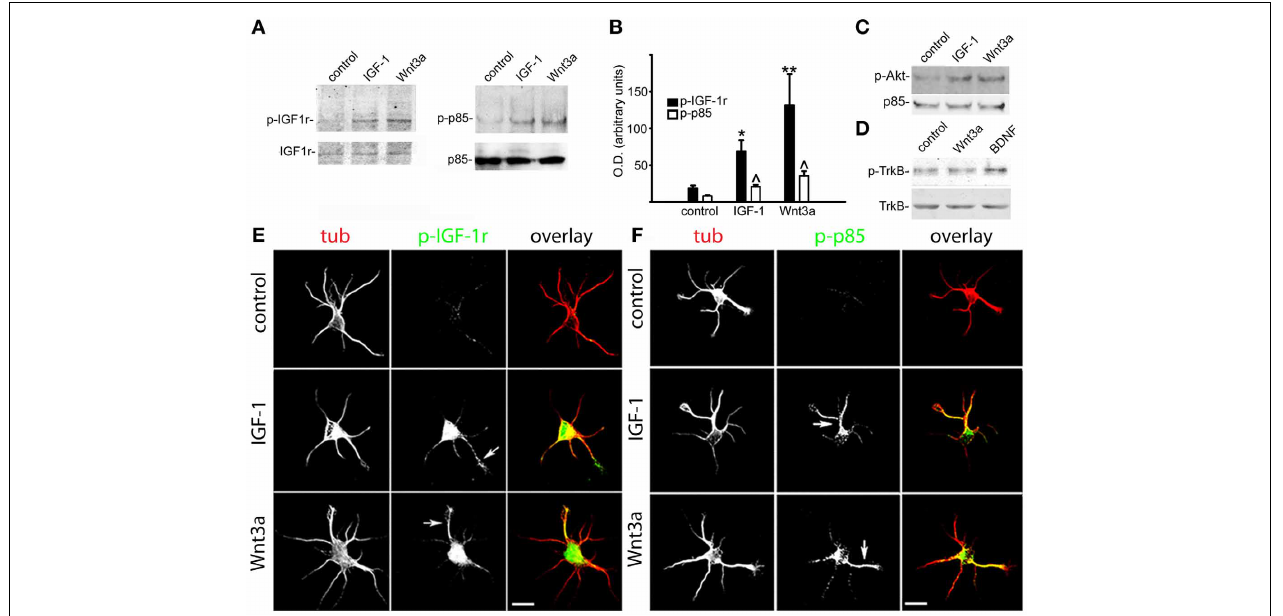
FIGURE 2 | Wnt3a elicited the polarized activation of IGF-1r and PI3k in hippocampal neurons. (A) Western blots of active (phosphorylated) IGF-1r (left) and phosphorylated p85 (right) in control GCPs and GCPs stimulated with either 20nM IGF-1 or 1.35nM Wnt3a. Growth cone particles were incubated for 30min on ice with growth factors and incubated at 37 ◦ C for 5min in the presence of 1mM ATP. Note the noticeable increment in both the active form of IGF-1r (left) and phosphorylated p85 (right). IGF-1r (left) or total p85 (right) were included as loading controls. (B) Relative optical densities of active IGF-1r and phosphorylated p85 in the western blots [similar to those shown in panel (A) ]. Note the significant increment of both active IGF-1r and phosphorylated p85 in the GCPs stimulated with IGF-1 ( ∗ p < 0 . 01; ∧ p < 0 . 05) or Wnt3a ( ∗∗ p < 0 . 001; ∧ p < 0 . 05) compared with control. Values are the average + sem of three independent experiments. (C) Western blots of active (phosphorylated) Akt in control GCPs or GCPs stimulated with either 20nM IGF-1 or 1.35nM Wnt3a. Growth cone particles were kept on ice for 30min with the growth factors and incubated at 37 ◦ C for 5min in the presence of 1mM ATP, p85 was included as a loading control. (D) Western blots of active (phosphorylated) TrkB receptors in control GCPs